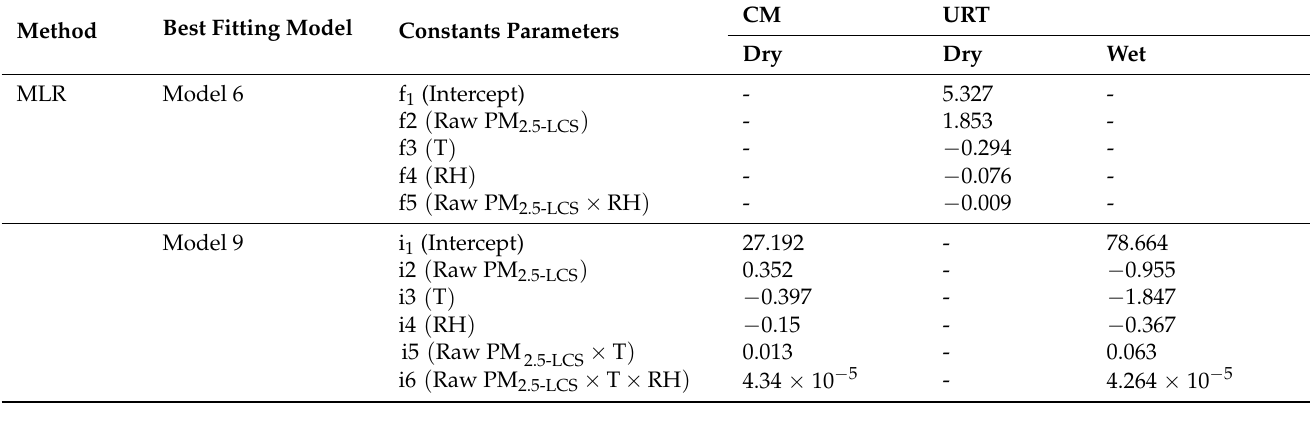
Table 6. MLR calibration: constants for the best fitting models.